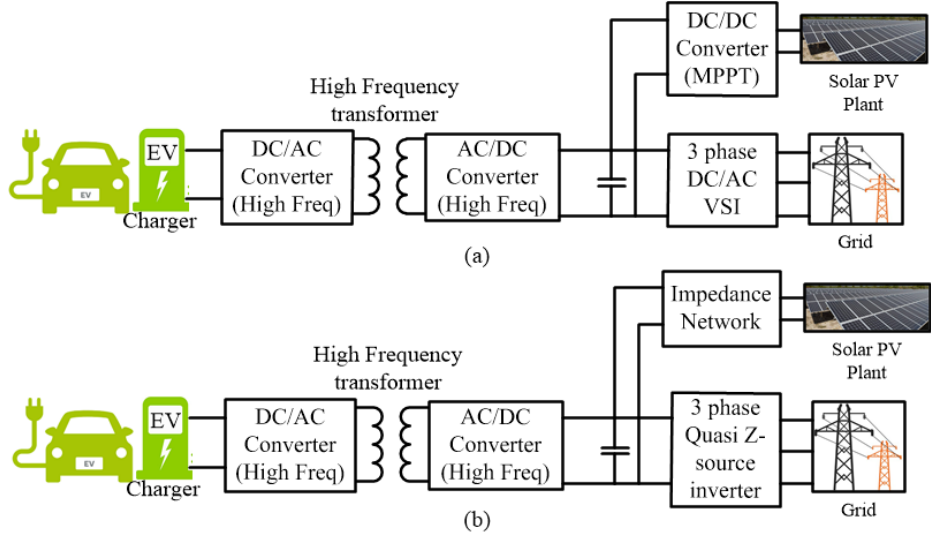
Figure 3. Block representation of grid-connected PV − EV converters ( a ) DC-link based converter, ( b ) Impedance-network based converter.